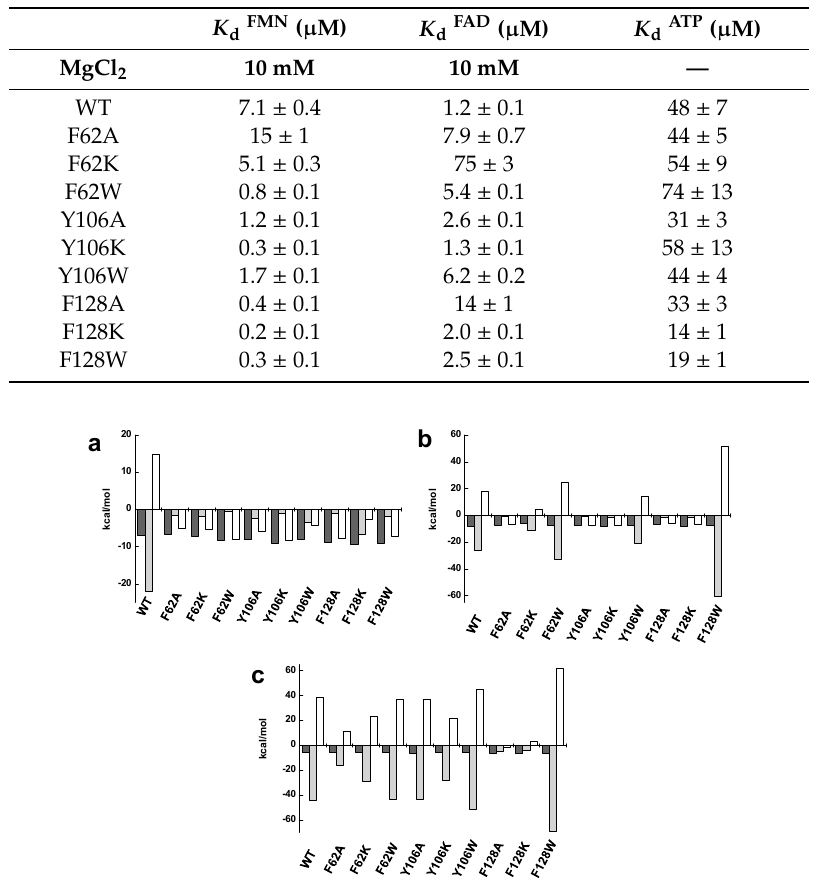
Figure 7. Thermodynamic contributions for ligand binding to Ca FADS variants. Thermodynamic dissections for the interaction of Ca FADS variants with ( a ) FMN, ( b ) FAD, and ( c ) ATP. The binding Gibbs energy ( ∆ G ), enthalpy ( ∆ H ), and entropy (-T ∆ S ) contributions to the binding are represented in dark grey, light grey, and white bars, respectively. Experiments were carried out at 25 °C in 20 mM PIPES, pH 7.0 for ATP, and in the presence of 10 mM MgCl 2 for FMN and FAD .